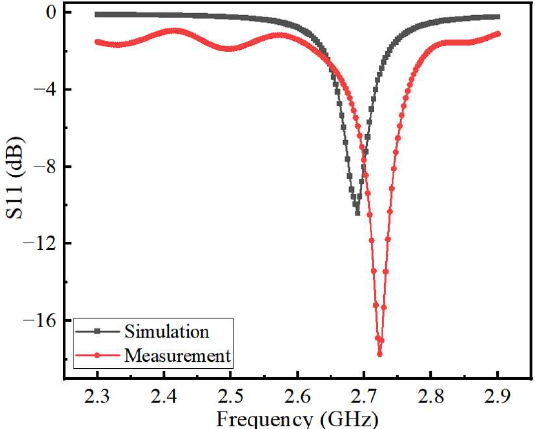
Figure 12. Plot of simulated versus measured results of S11 parameters.